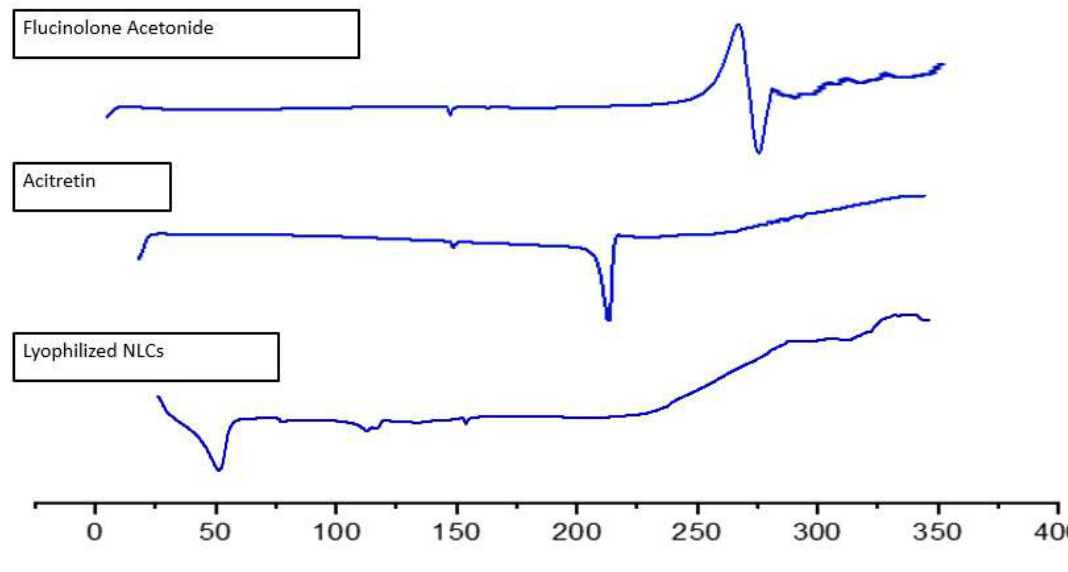
Figure 5. DSC analyses of fluocinolone, acitretin and optimized FLU–ACT-coloaded NLCs.